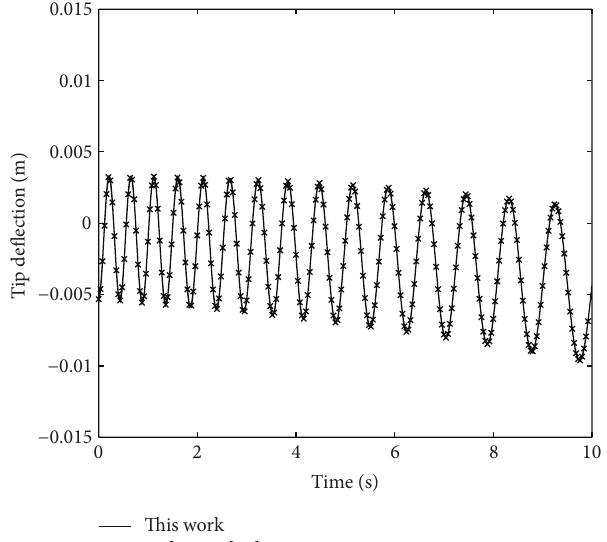
Figure 3: Tip deflection of the axially translating and rotating beam ̇𝜃 = 0.785 when 𝐿(𝑡) = 1.8 + 0.1𝑡 , rad/s.